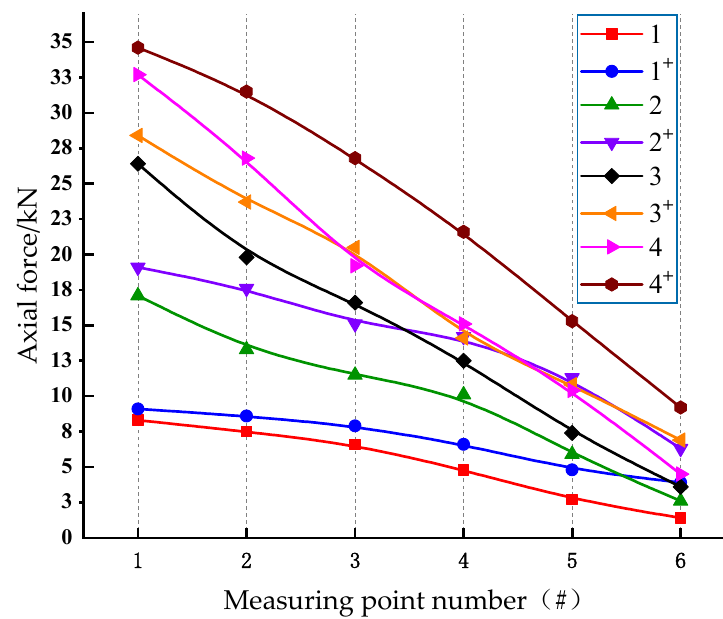
Figure 14. Change curves of the axial force of bolts.